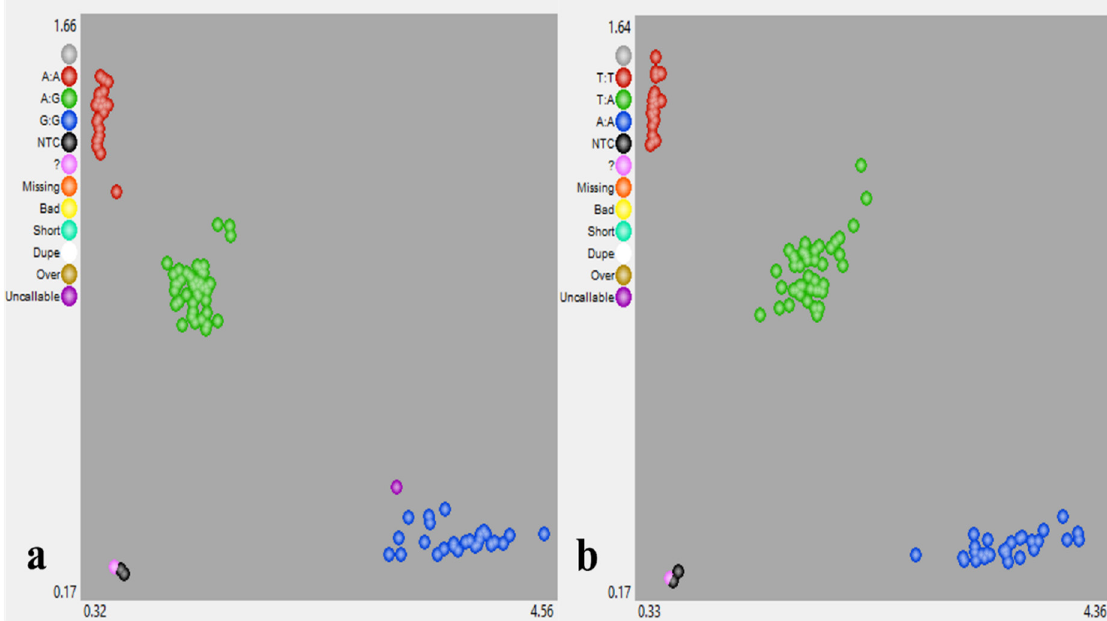
Figure 2. Cluster genotype of KASP molecular markers ( A ) snpOS00938 and ( B ) snpOS00941 using F 2 segregating popu- lation.